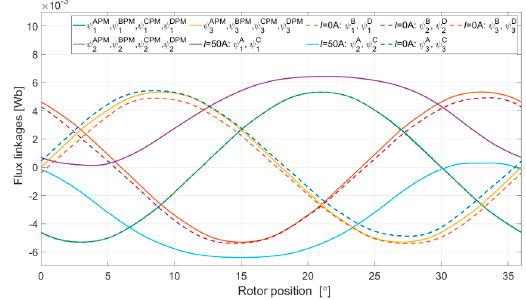
Figure 7. Flux linkages vs. rotor positions for DCO A and C—variant I.